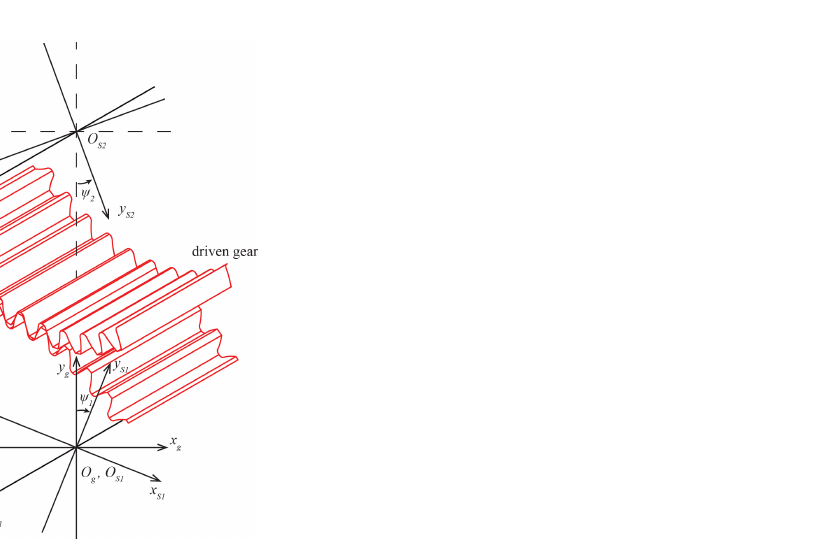
Figure 3. Relationship between the coordinate systems of the spur gear